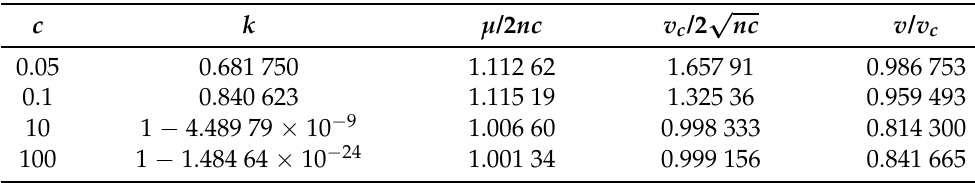
Figure 9. Density profiles of the quantum double dark soliton ρ Q ( x ) (red solid curves) and the corresponding elliptic solutions (blue broken curves) for N = L = 20, X 1 = L /4, X 2 = − L /4, and coupling constants c = 0.05, 0.1, 10, and 100. The parameters of the elliptic solutions are shown in Table 3. Table 3. Parameters of the elliptic solutions for Figure